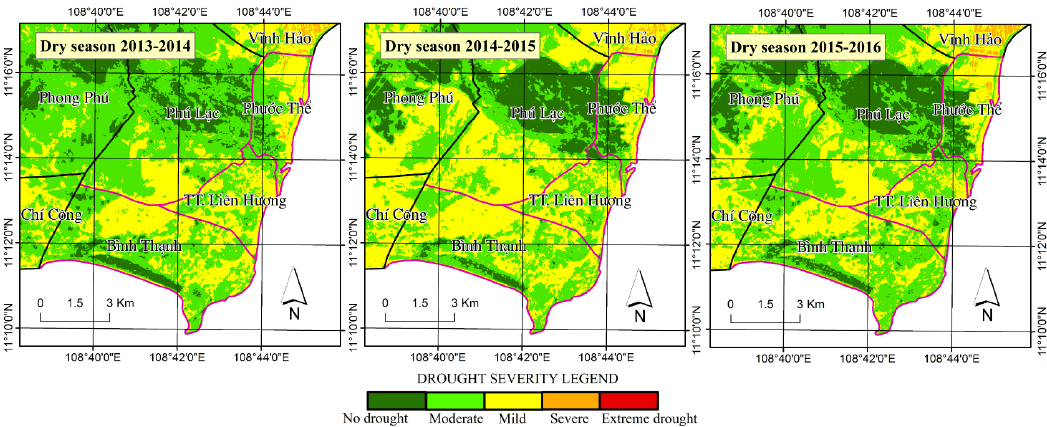
Figure 4. Agricultural drought severity during dry seasons from 2013 to 2016 in the study area (red color border) in Tuy Phong district, Binh Thuan. The study area was indicated under moderate to mild impact of drought. The analysis was based on assessing spatial and temporal Vegetation Health Index distribution via Landsat images over 27 years